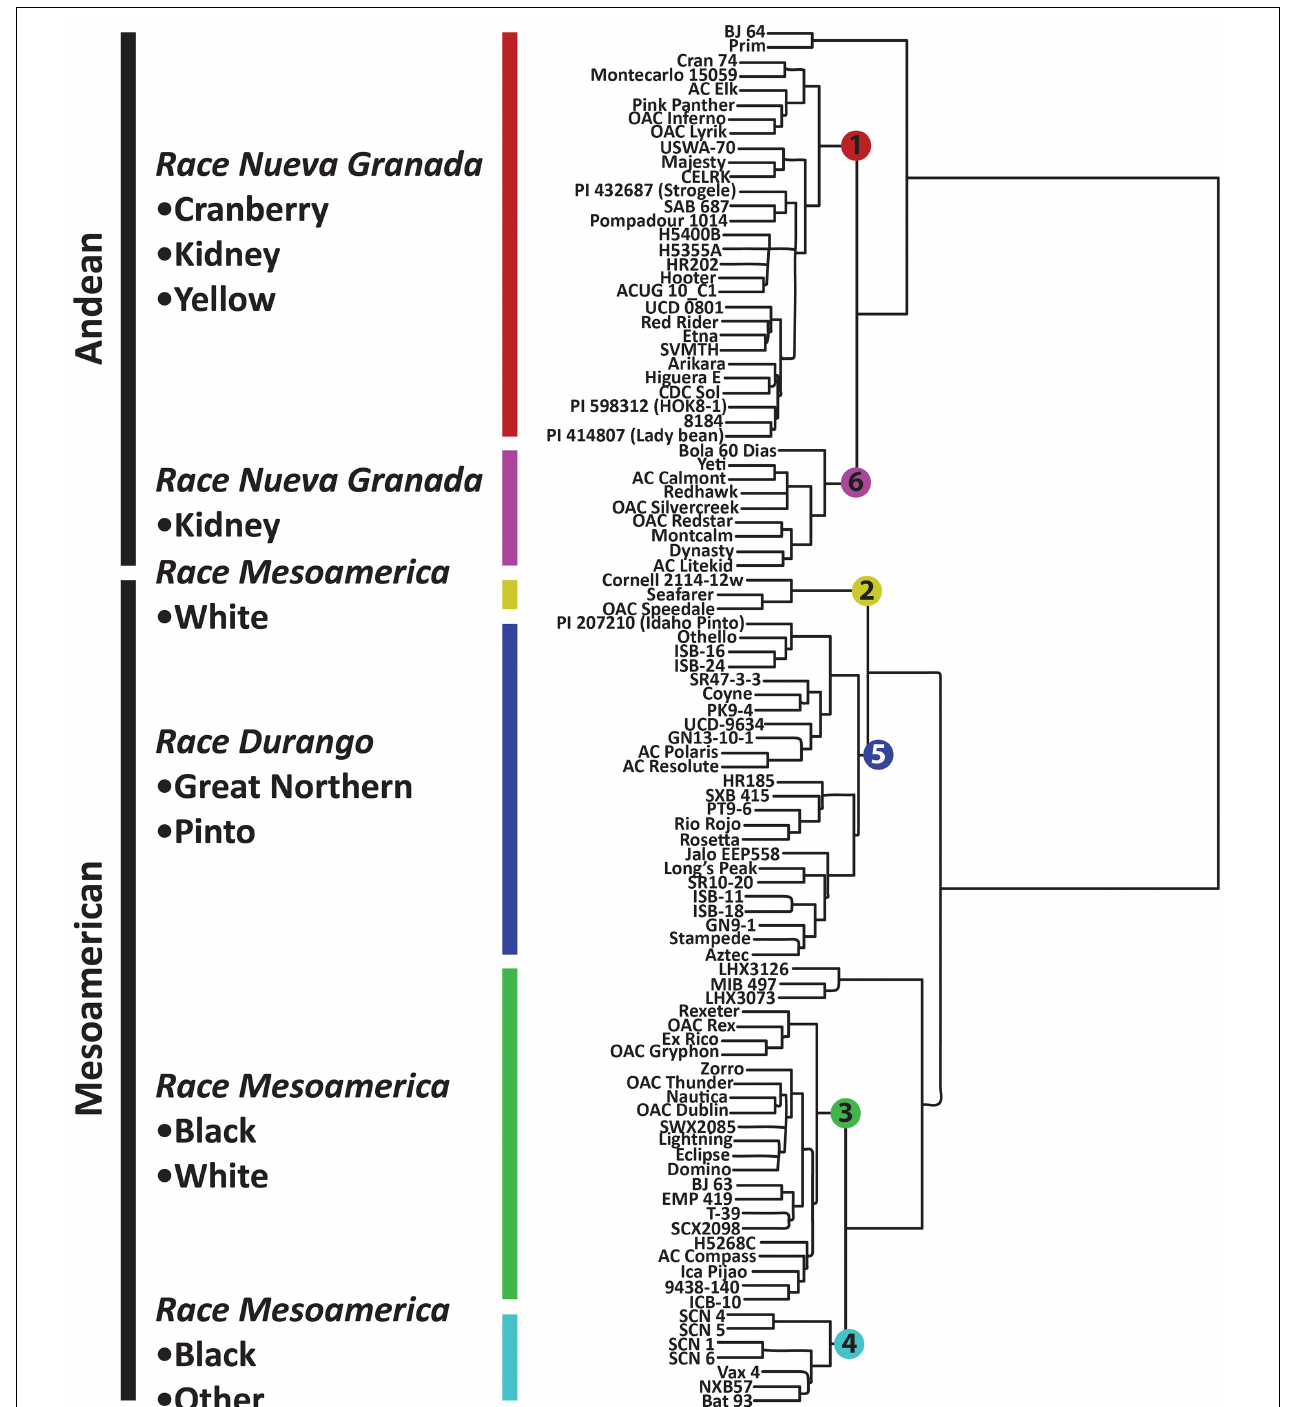
FIGURE 3 | Hierarchical clustering of P. vulgaris accessions in the diversity panel based on 2,522 SNP markers. The dendrogram was generated in Flapjack using the default parameters (Milne et al., 2010).